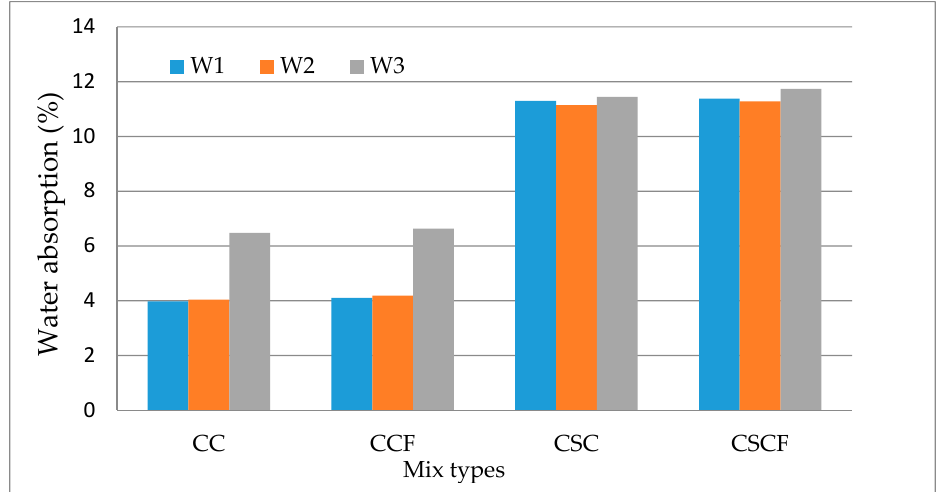
Figure 5. Results of water absorption test.